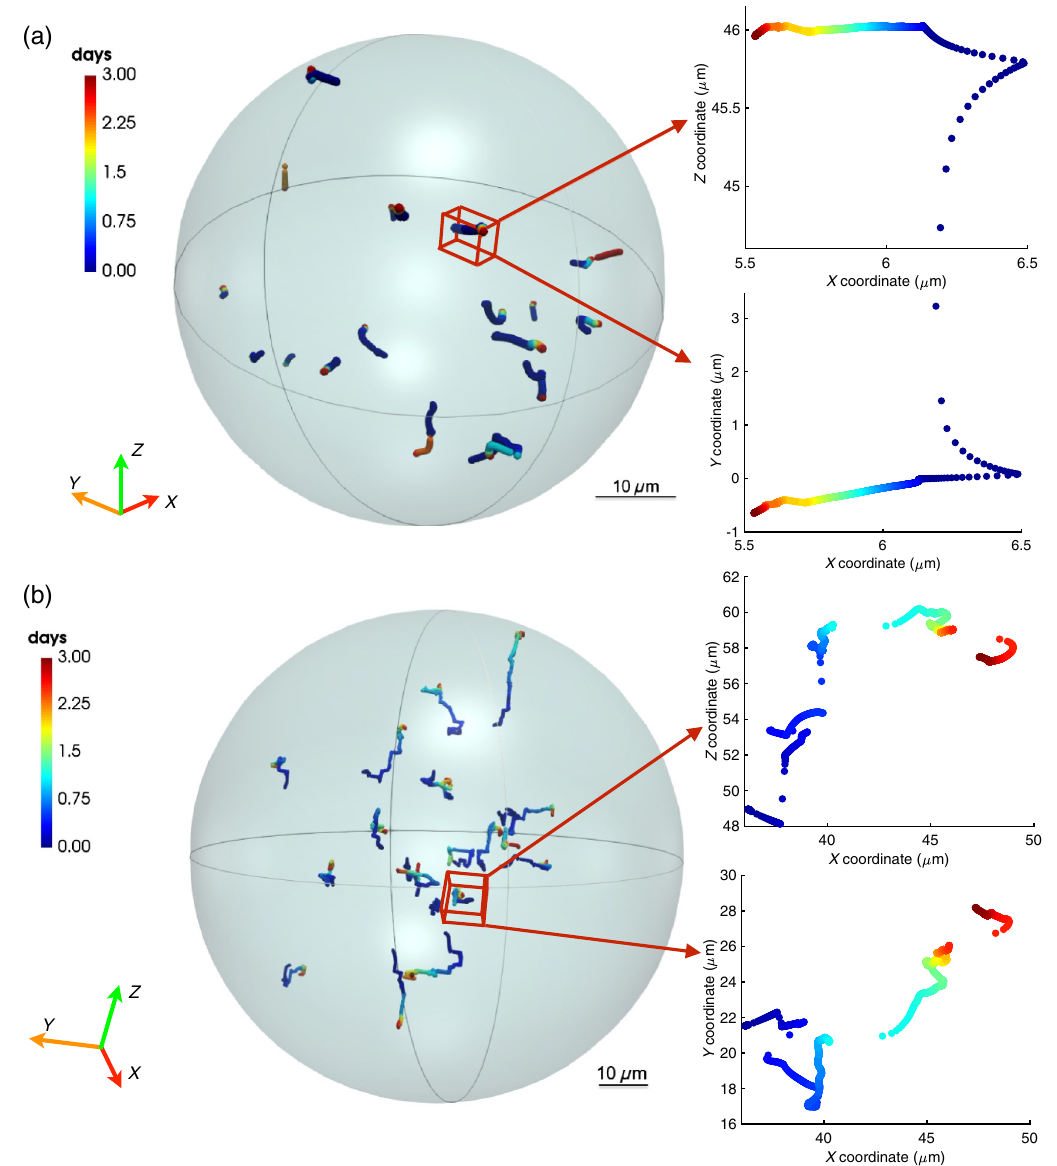
FIG. 10. Trajectories displaying spatial heterogeneity. (a) Trajectories (randomly chosen from the whole tumor) for slowly growing cells are shown. The cell cycle time is 15 τ . Dynamic arrest due to caging in the glasslike phase is vividly illustrated. (b) Trajectories min for rapidly growing cells with cell cycle time τ ¼ 0 . 25 τ . Displacements of the cells are shown over 3 days, representing the initial min stages of tumor growth in (a) and (b). Two representative trajectories (time dependence of the x − z and x − y coordinates) for the labeled cells are shown on the right in (a) and (b). Length in (a) and (b) is measured in units of μ m. The two colored spheres in (a) and (b) show the approximate extent of the